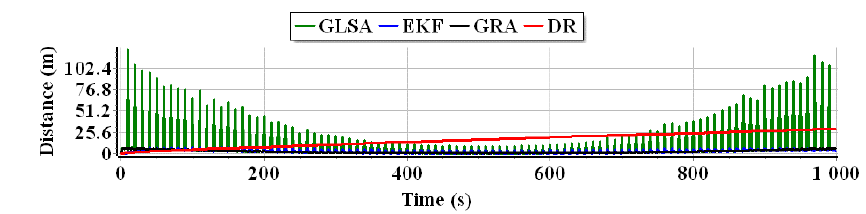
Figure 8. Arithmetic mean distance to reference position from the estimated position during 100 SV crossings as a function of time.